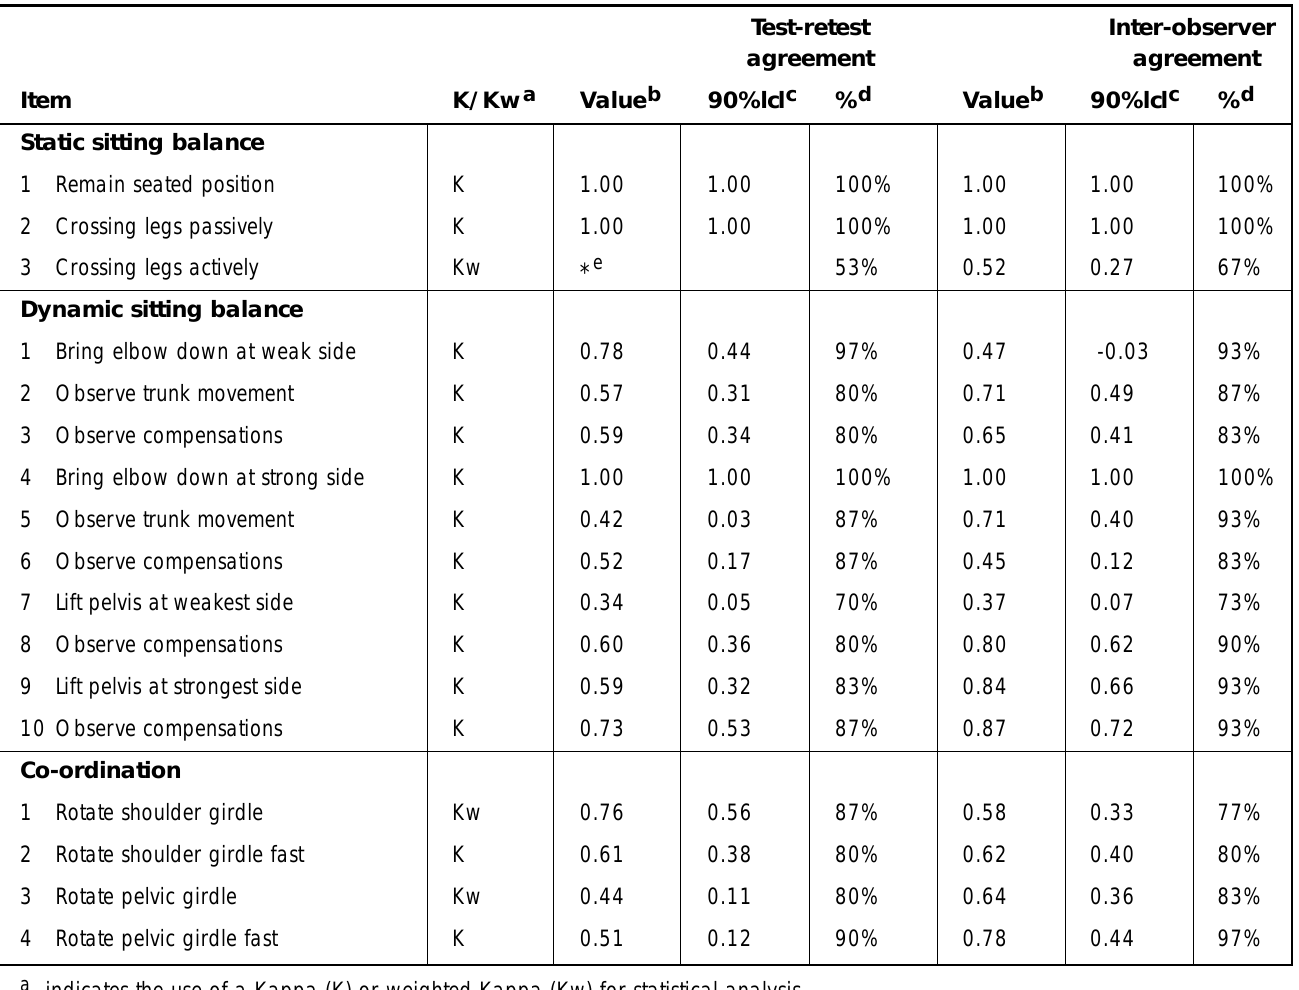
Table 1: Kappa or weighted Kappa, lower value of the 90% confidence limit of the Kappa or weighted Kappa and percentage of agreement for test-retest and inter-observer